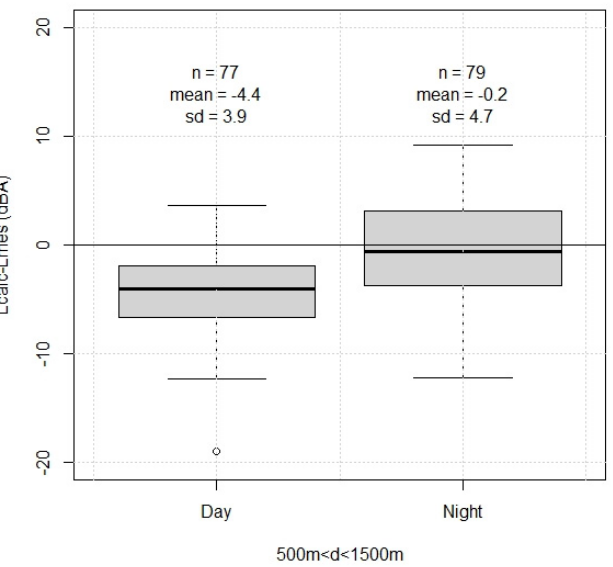
Figure 4. Boxplot of the difference between predicted and measured sound levels, for two typical meteorological conditions during the day and night. The wind speed was above 6 m/s and the distance from the wind turbine ranged from 500 m to 1500 m. Number of samples (n), bias (mean), standard uncertainty (sd).